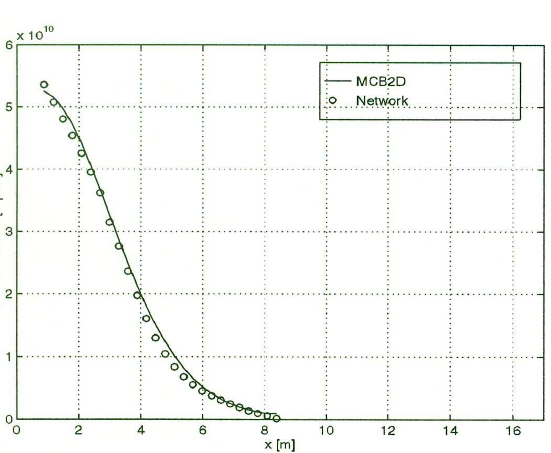
Fig. 4.1. Network 1, v/R= 4.34 (cid:215) 10 -4 m/d, e test